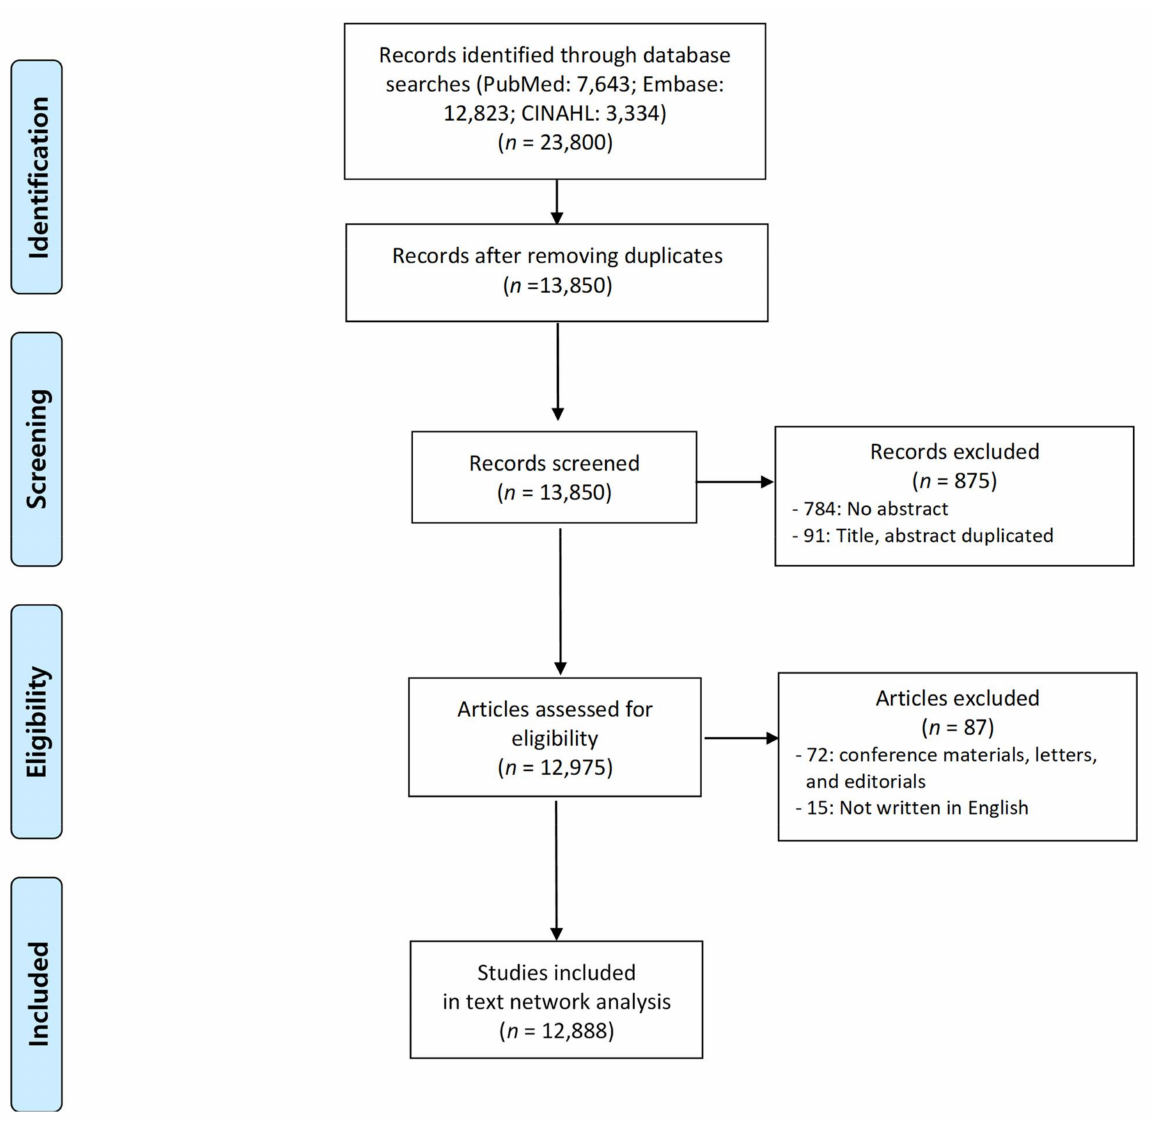
Figure 1. The flowchart of article inclusion